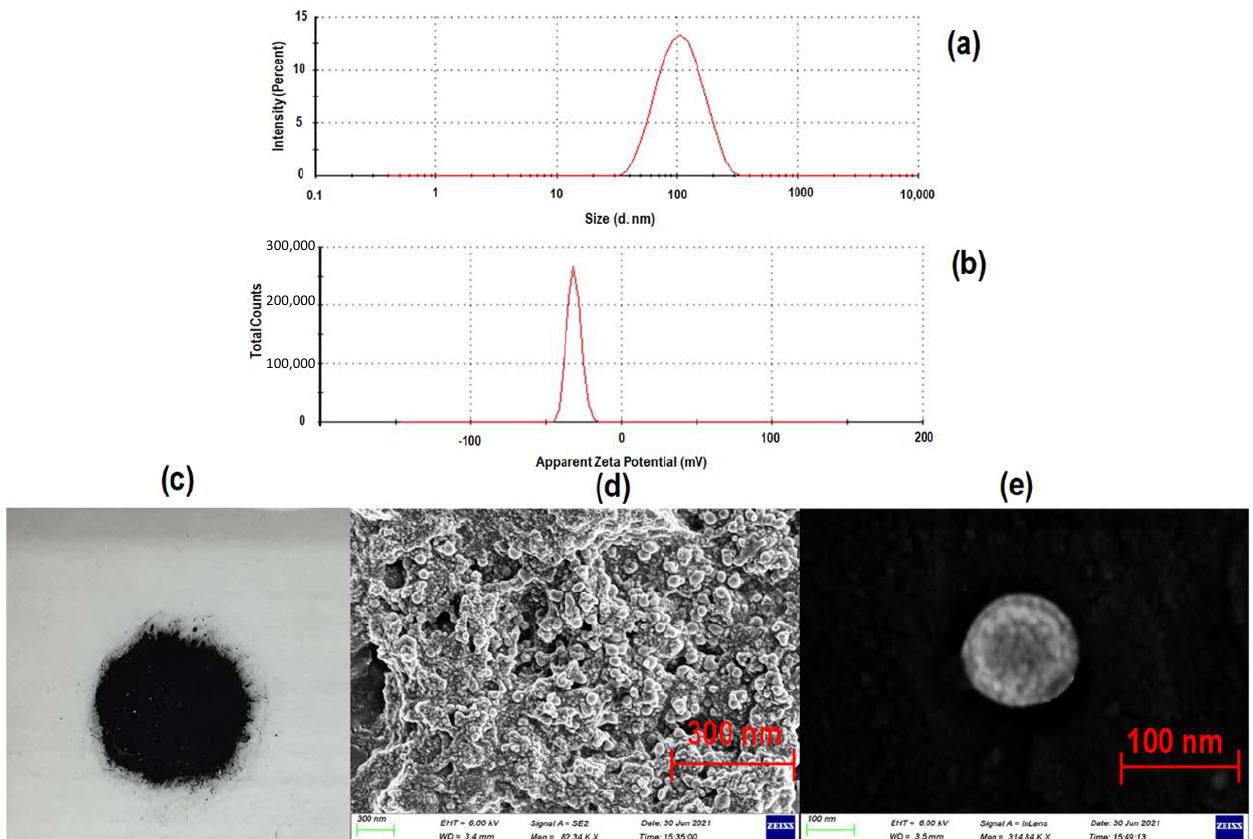
Figure 1. A visualization of the morphological attributes of the CLA-coated PTX-SPIONs, showing ( a ) average hydrodynamic particle size of 96.5 ± 0.6 nm (PDI = 0.1 ± 0.02), ( b ) zeta potential of − 27.3 ± 1.9 mV, and ( c ) digital image of a lyophilized sample with corresponding SEM images showing overall morphology ( d ) at 300 nm scale (82.34 KX magnification) and ( e ) 100 nm scale (314.84 KX) (isolated particle), showing a particle size of <100